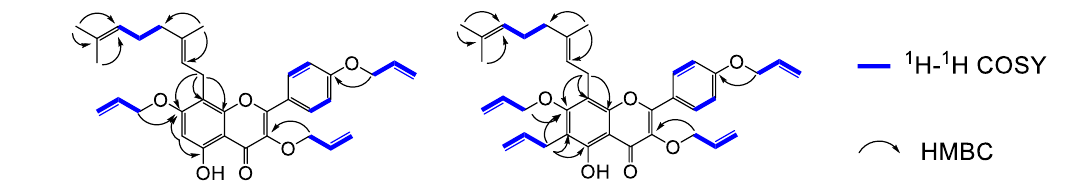
Figure 2. Keys 1 H− 1 H COSY and HMBC correlations of compounds 6a and 6b. Figure 2. Keys 1 H − 1 H COSY and HMBC correlations of compounds 6a and 6b